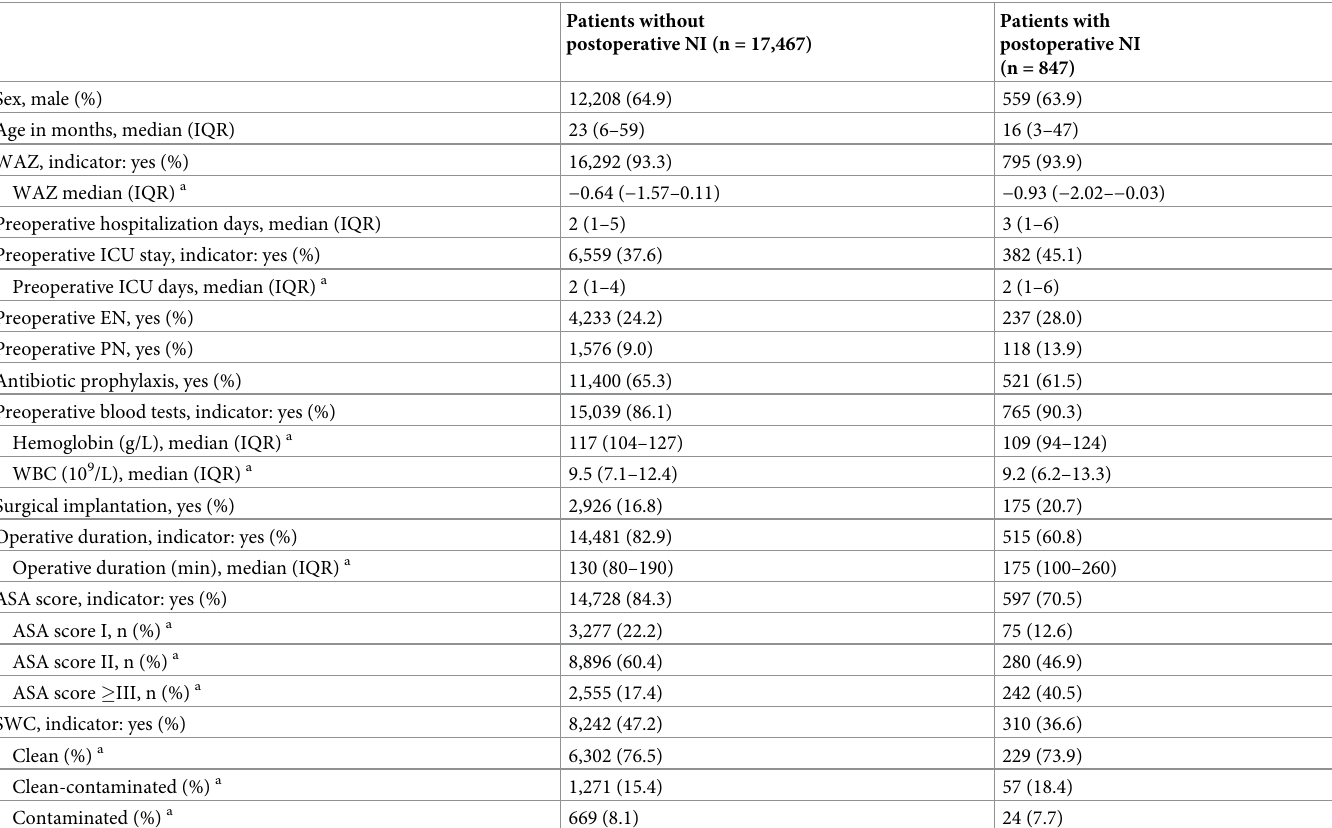
Table 1. Baseline characteristics of a retrospective cohort of pediatric patients who underwent invasive operations (n = 18,314), stratified by postoperative NI sta- tus, the Guangzhou Women and Children’s Medical Center,